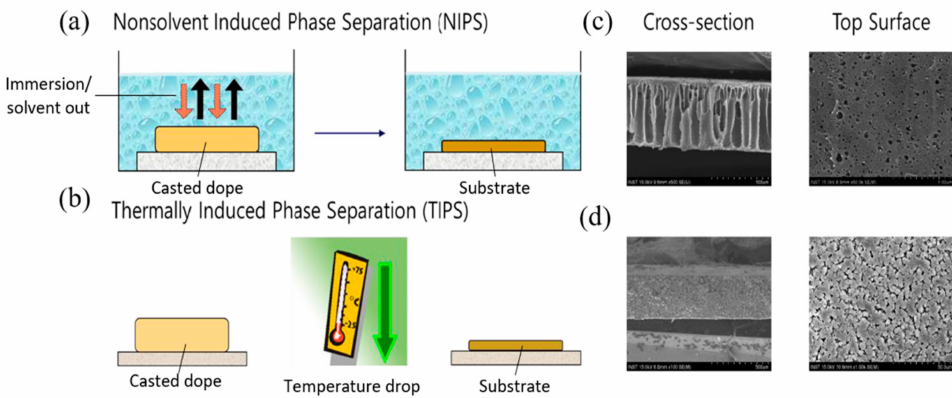
Figure 1. Phase inversion using: ( a ) NIPS; ( b ) TIPS with their respective ( c ); ( d ) cross-section and top surface morphologies